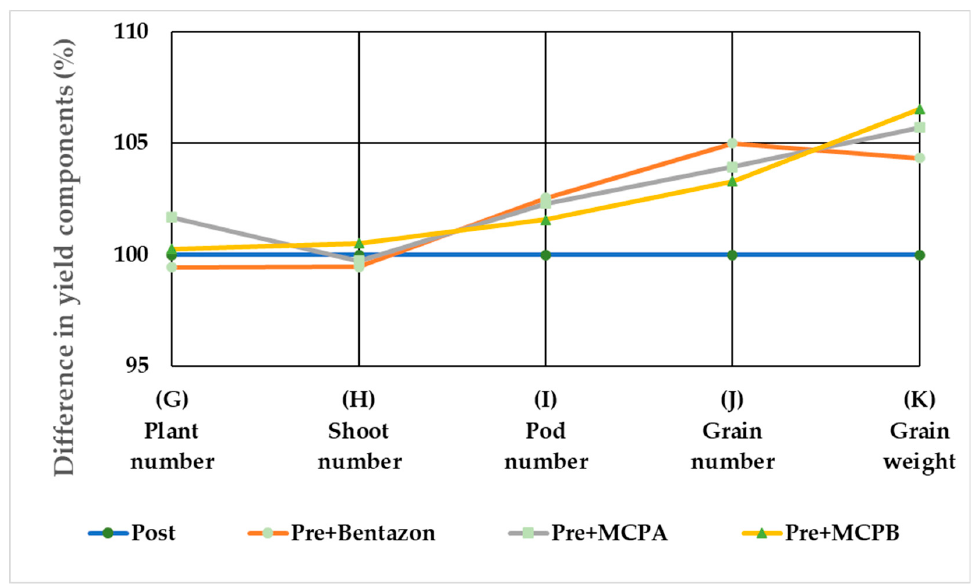
Figure 9. The effect of pre-emergence treatments on the development of winter pea ( Pisum sativum L.) in post-emergence weed management at stem elongation, over an average of 2 years.